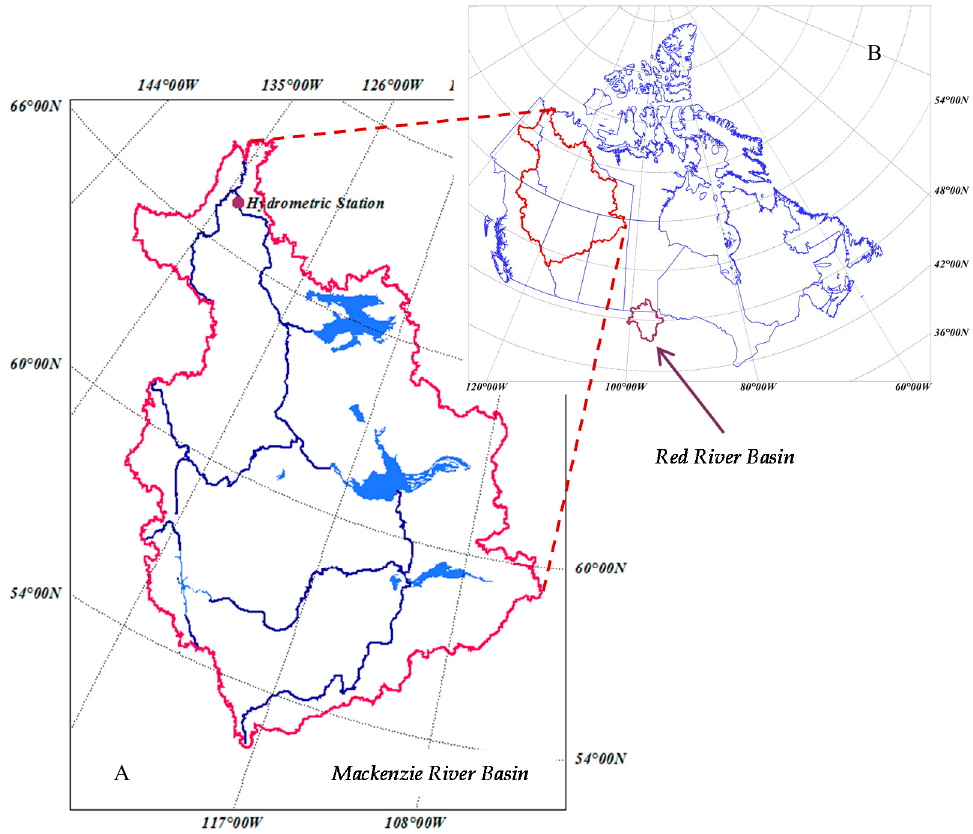
Figure 1. Map for the the Mackenzie River Basin (MRB) and the hydrometric station for river flow measurement ( A ), and its location in Canada’s landmass ( B ). The Red River Basin (RRB) is also shown on the map of Canada.